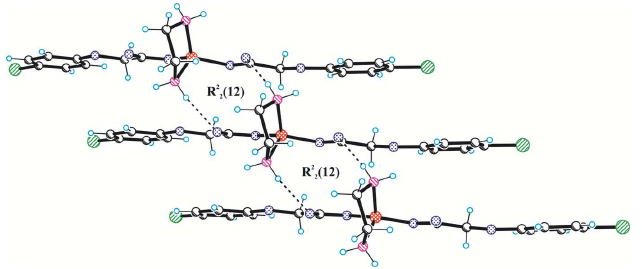
Figure 2 Formation of chains and hydrogen bonds in the title complex. Hydrogen bonds are shown as dashed lines.